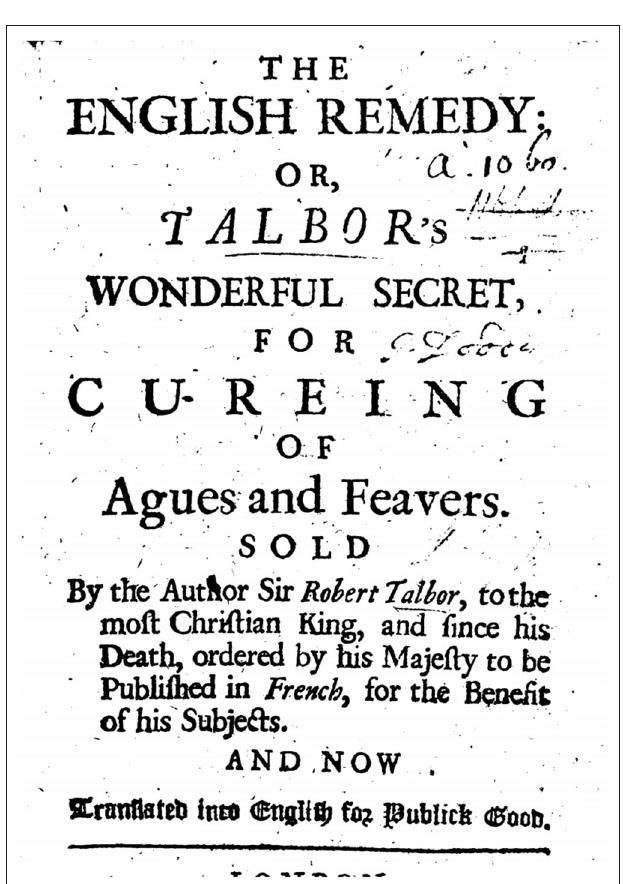
FIGURE 2 | The english remedy: Talbor’s wonderful secret for curing of agues and feavers (47).